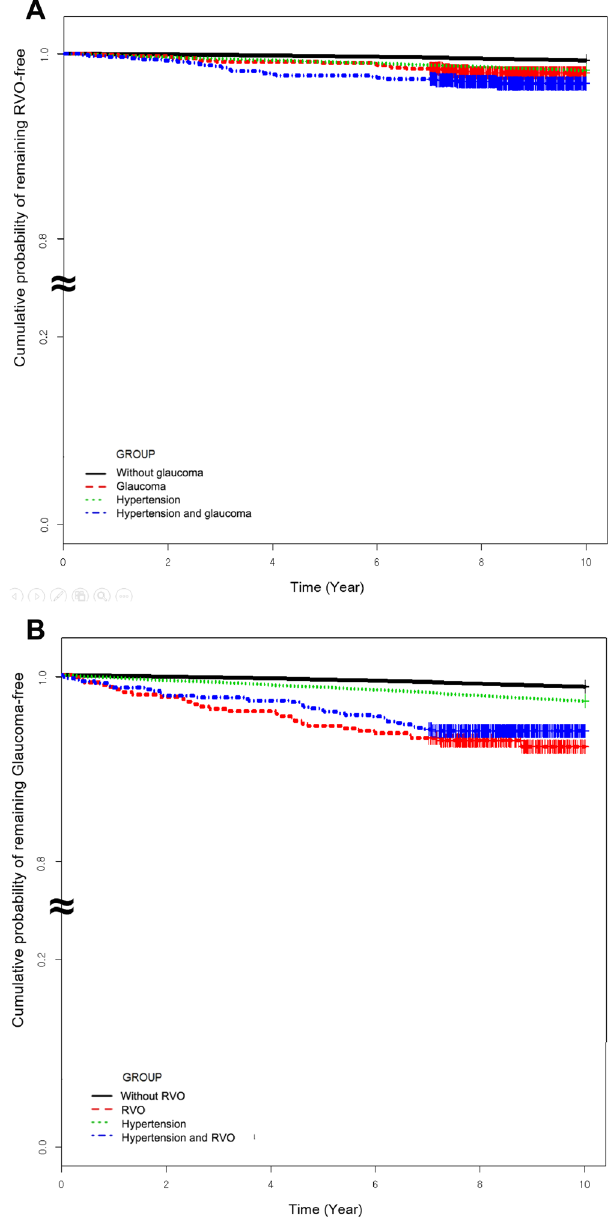
Figure 1. The results of Kaplan-Meier survival analysis. ( A ) Primary open-angle glaucoma (POAG) development in patients with retinal vein occlusion (RVO). ( B ) RVO development in patients with